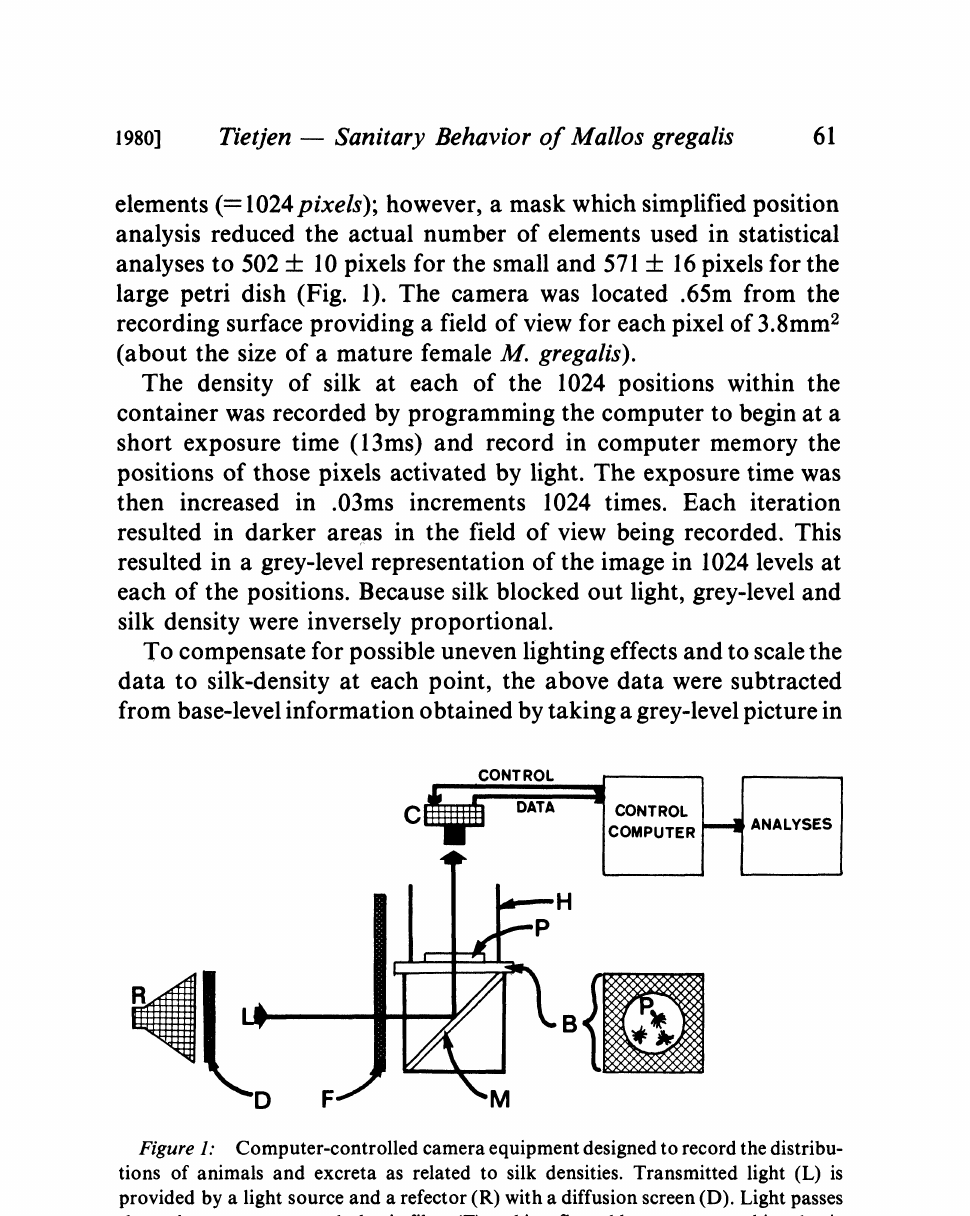
Figure 1: Computer-controlled camera equipment designed to record the distribu- tions of animals and excreta as related to silk densities. Transmitted light (L) is provided by a light source and a refector (R) with a diffusion screen (D). Light passes through a transparent red plastic filter (F) and is reflected by an opaque white plastic mirror (M) which provides for further diffusion of the light. The light passes through a clear plastic base (B) and into a petri dish (P) which holds the experimental colony. An opaque mask blocks light outside the colony recording area and a hood (H) surrounding the recording area reduces the ambient light level seen by the camera (C). The camera is controlled by a computer which also receives the image data. This information is transmitted to a second computer for numerical